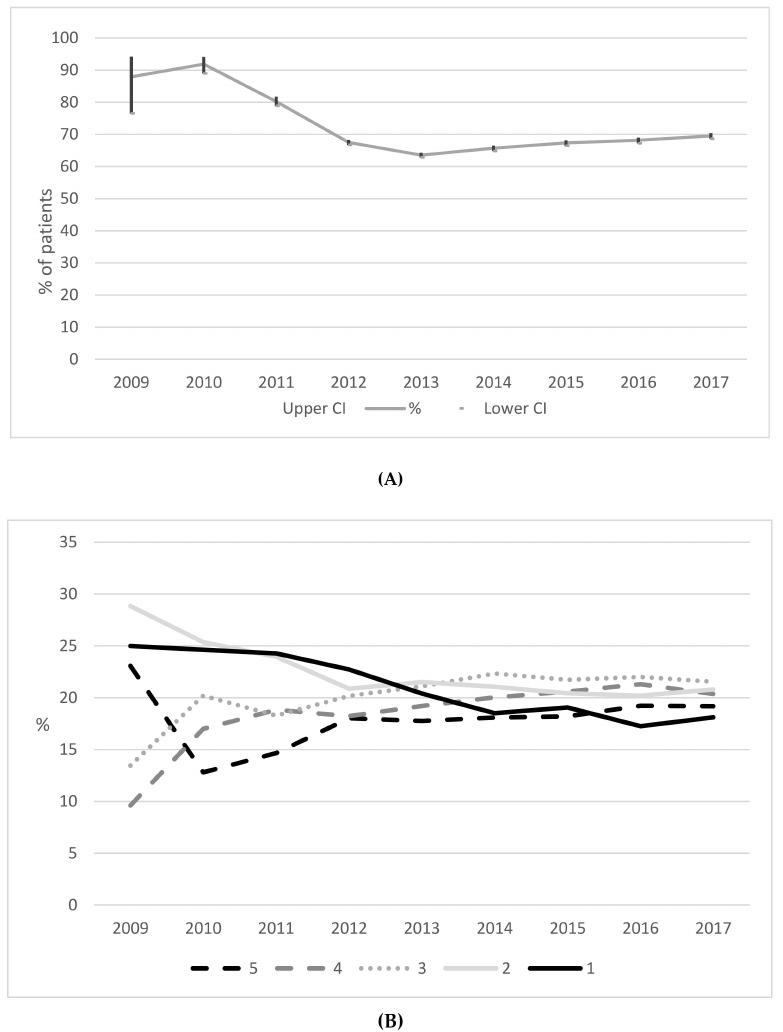
Figure 4. ( A ) Percentage of generic pathway patients taking up NERS across 2009 to 2017 (95%CI) ( N = 75,470 patients). ( B ) Percentage of generic pathway patients up taking NERS across 2009 to 2017 according to deprivation quintile (5 = least deprivation, 1 = most deprived) ( N = 69,316